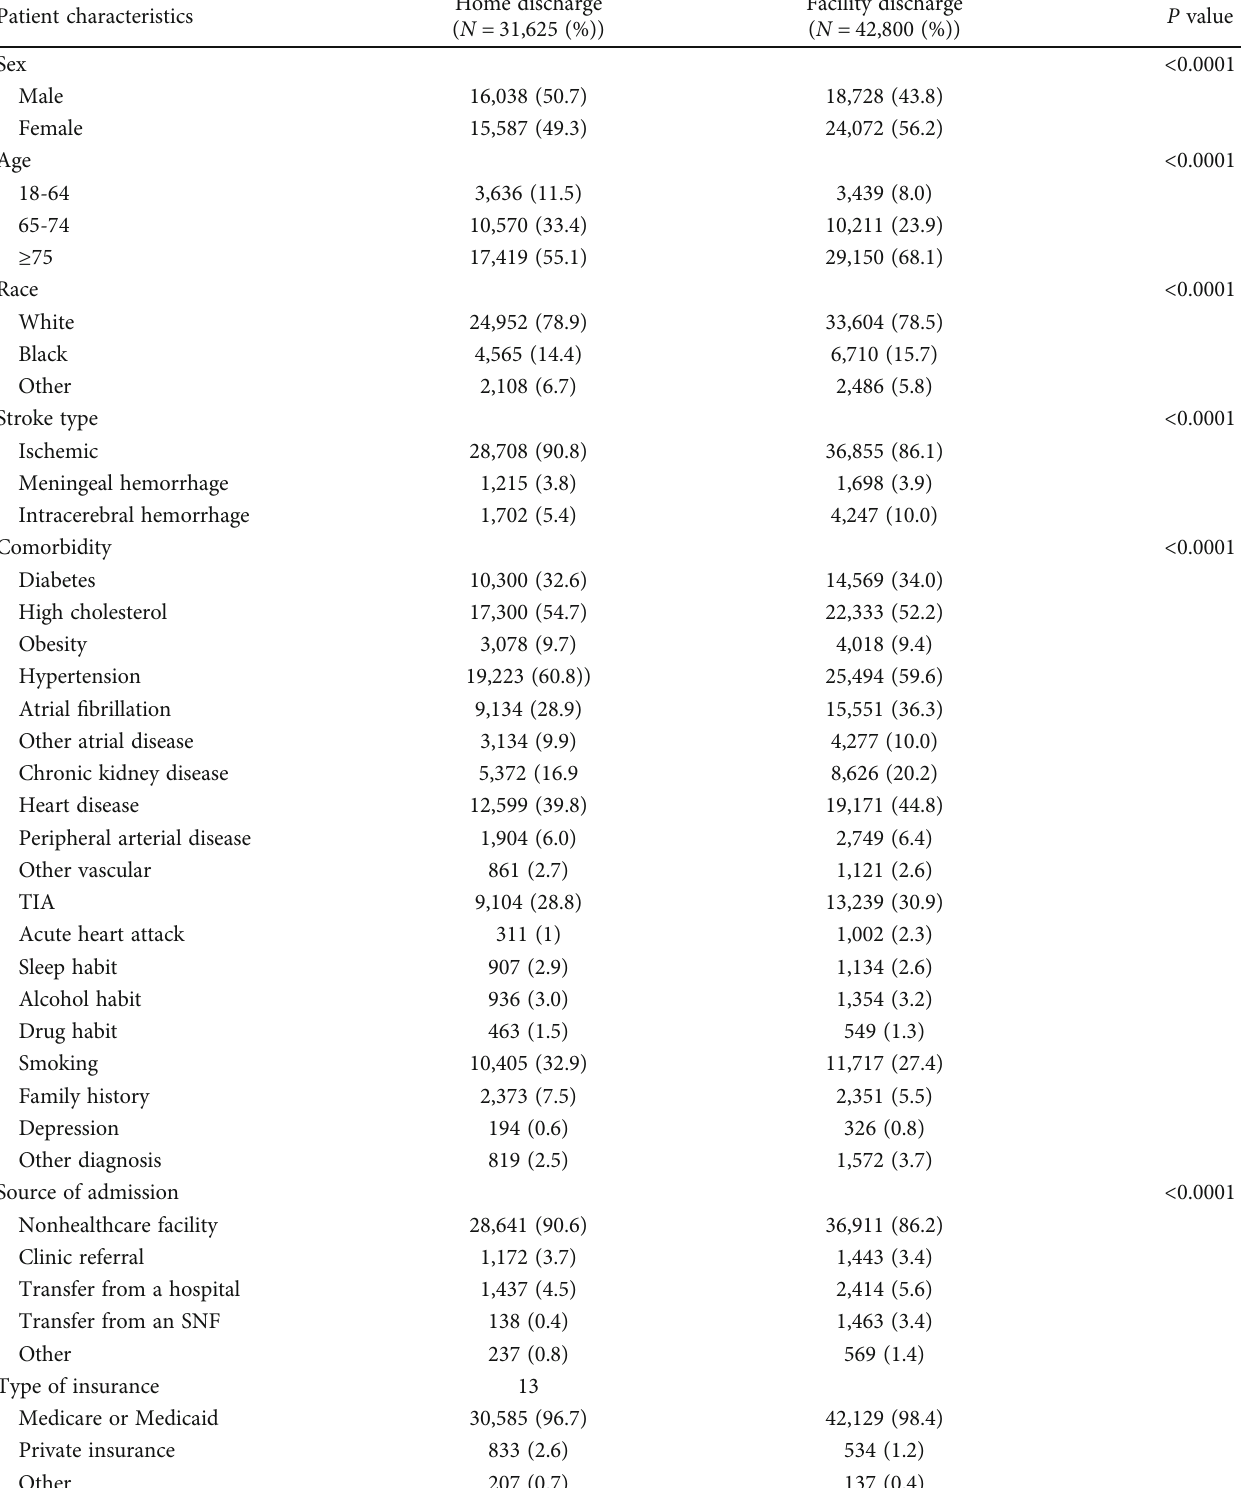
Table 1: Demographic and clinical characteristics of patients with primary diagnosis of stroke by hospital discharge disposition